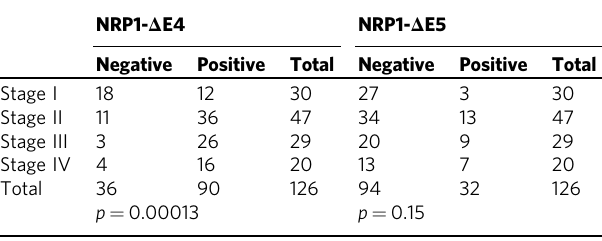
Table 1 Expression of NRP1- Δ E4 and NRP1- Δ E5 in CRC